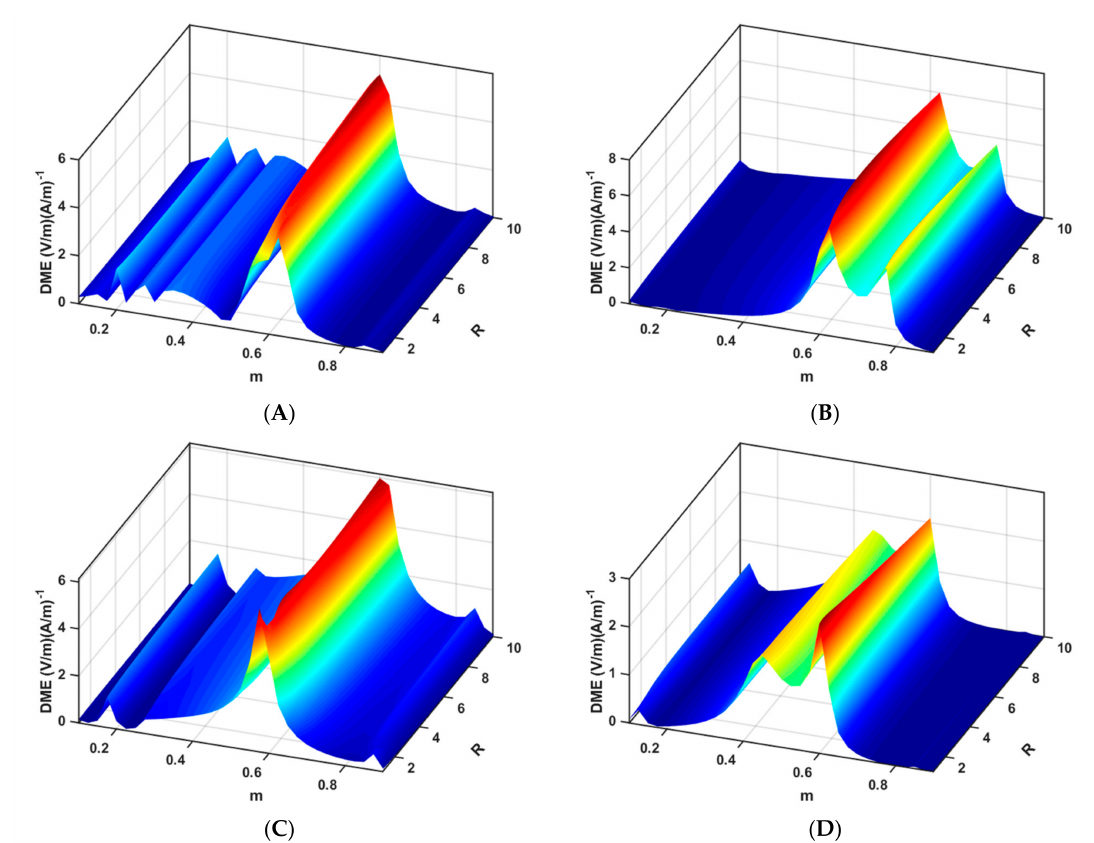
Figure 4. The peak DME values at the resonant frequency as function of the m and R ratio for ( A ) C-C, ( B ) F-F, ( C ) F-C, and ( D ) C-F boundary